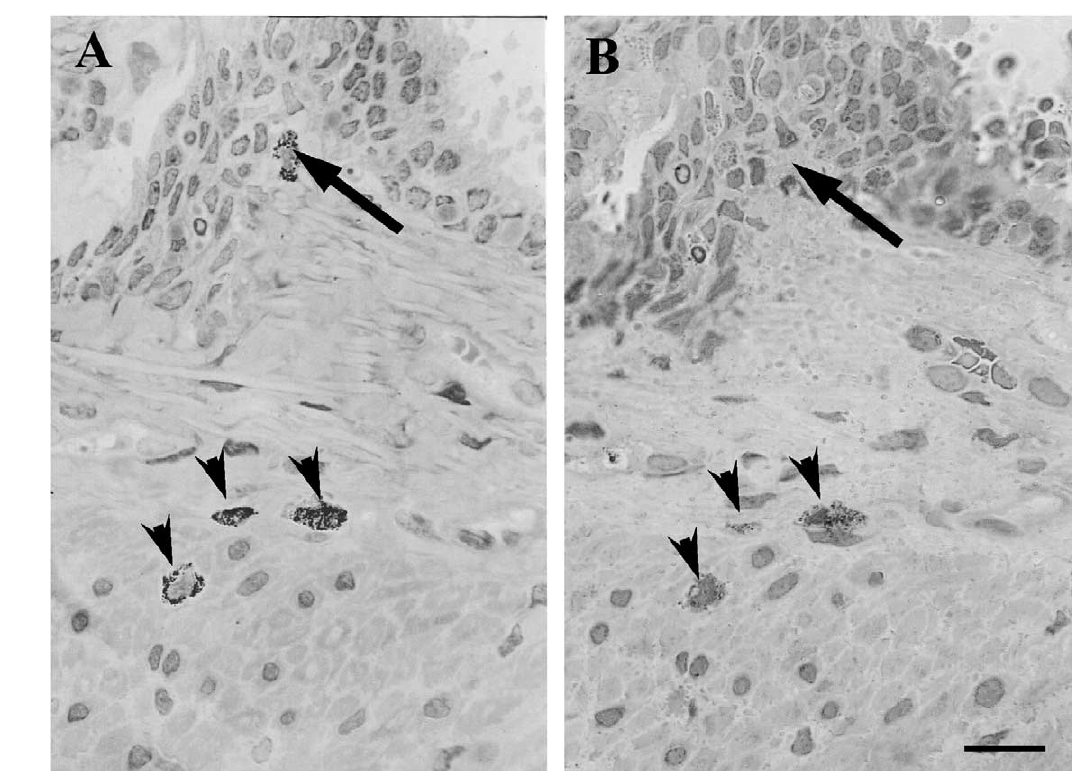
FIG. 1. Morphology of MMC and CTMC in rat trachea tissue sections. (A) Tracheal MMC in the basal group showed metachromatic cytoplasmatic granules in the mucosal layer (arrow), whereas the CTMC subtype was predominantly localized in smooth muscle and adventitious layers (arrowheads). Toluidine blue stain. (B) Presence of ST-1 (anti-heparin monoclonal antibody) immunoreactivity in CTMC (arrowheads) and absence of staining in MMC (arrow). Hematoxylin and eosin stain. Bar, 10 m m.